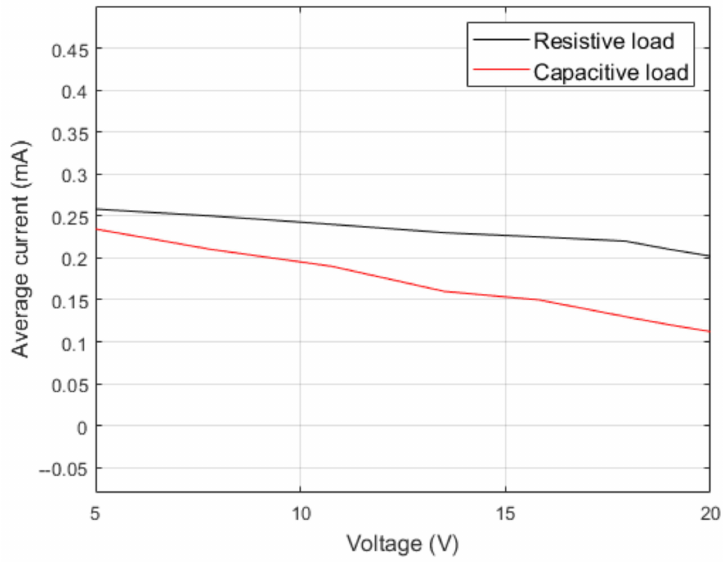
Figure 14. Average current for capacitive and resistive load of